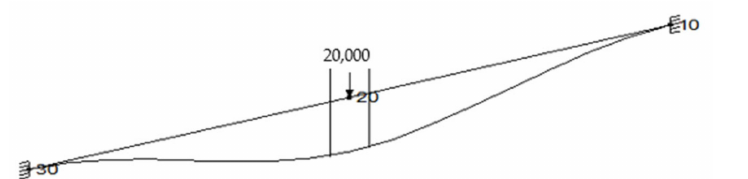
Figure 5. Example of the graphical results of the shorter model: pipeline deflection for δ = 0.4 mm.